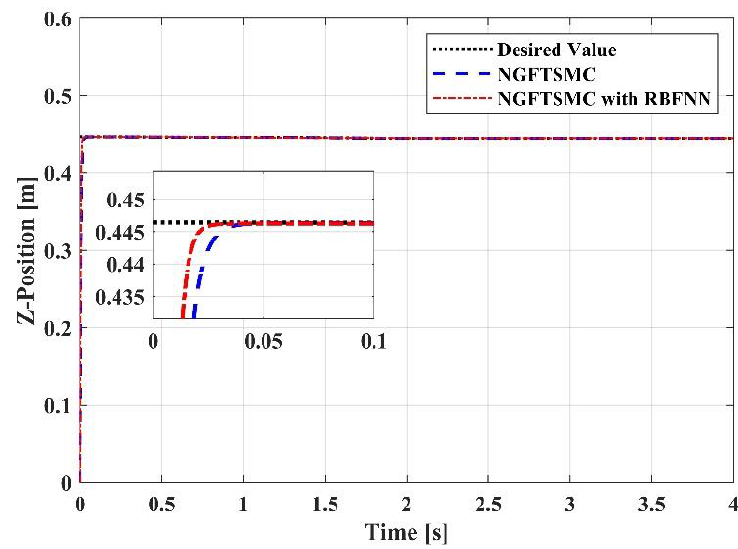
Figure 8. The trajectory tracking results in Z-Position.